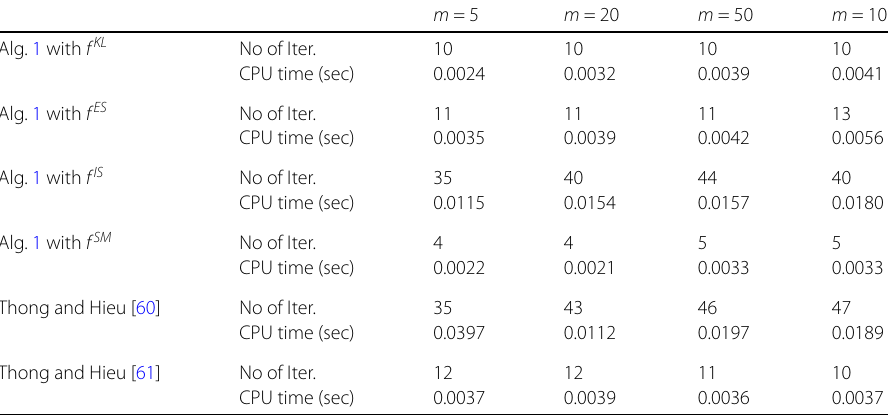
Table 1 Computation result for Example